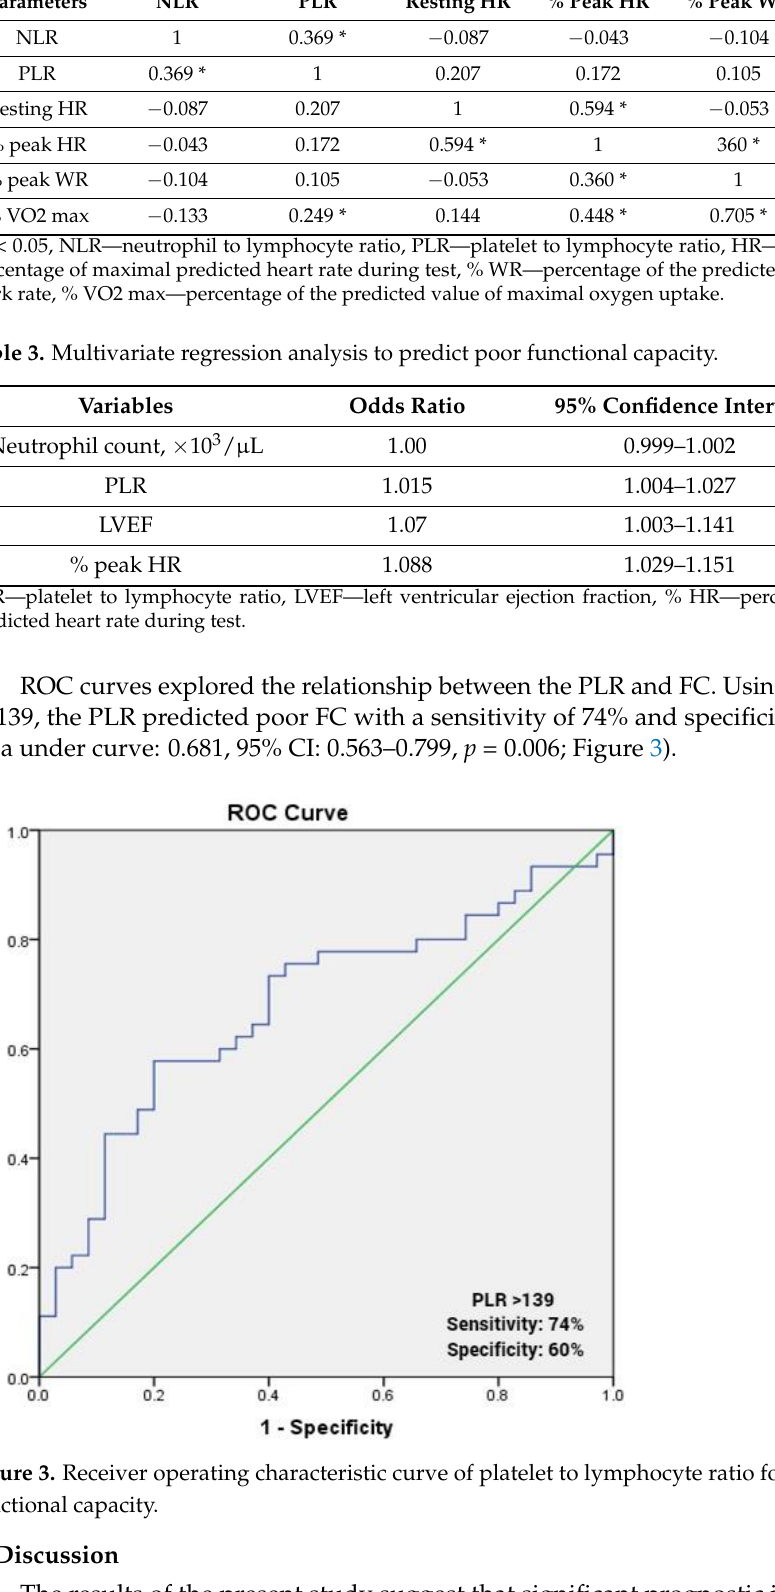
Table 2. Pearson correlation between NLR, PLR and CPET parameters.